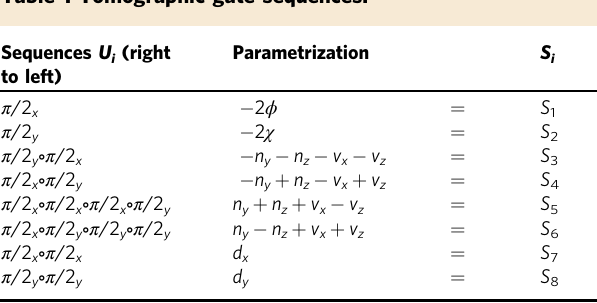
To fi rst order, the outcome of the measurement Tr ð σ z U i 0 j i 0 h j U y i Þ ¼ S i depends linearly on the gates ’ rotation-angle errors 2 ϕ (2 χ ), the axis-errors n y , n z ( v x , v z ) and decoherence d x ( d y ) of the